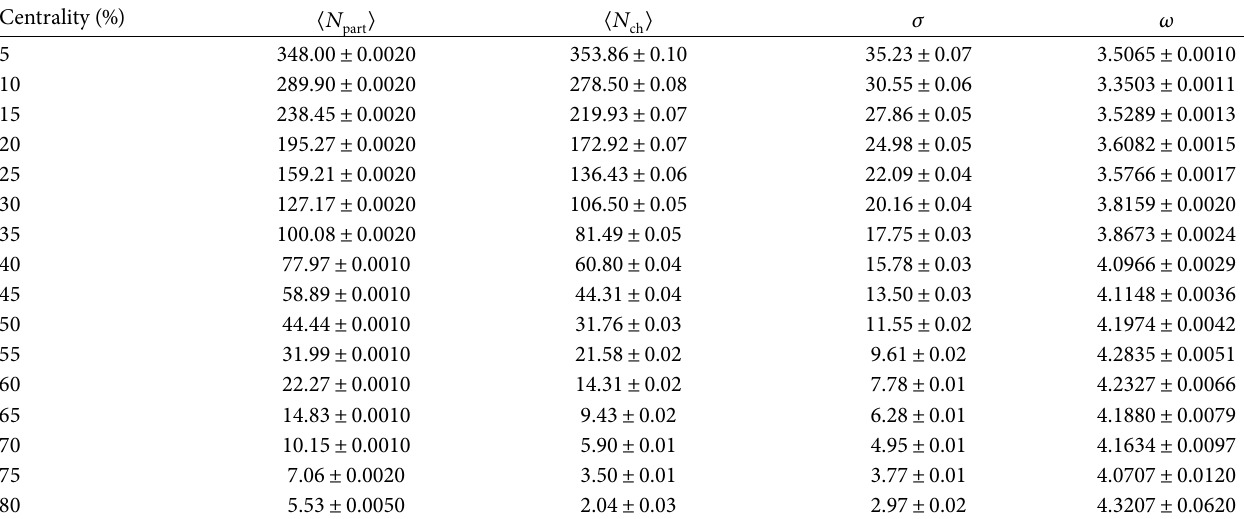
Table 4: Values of the same variables, as in Table 1, but for 𝐸 lab = 40A